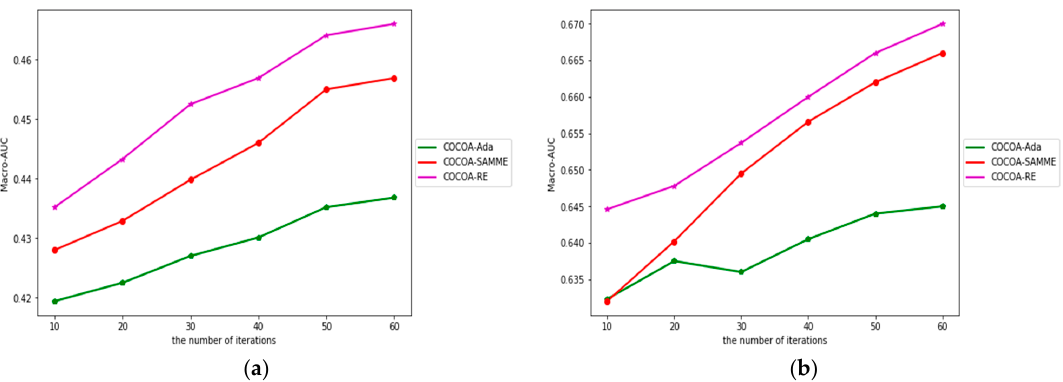
Figure 5. The results with changing iterations using decision tree as the binary-class classifier: ( a ) the Macro-F values of comparable approaches in different iterations; ( b ) the Macro-AUC values of comparable approaches in different iterations.